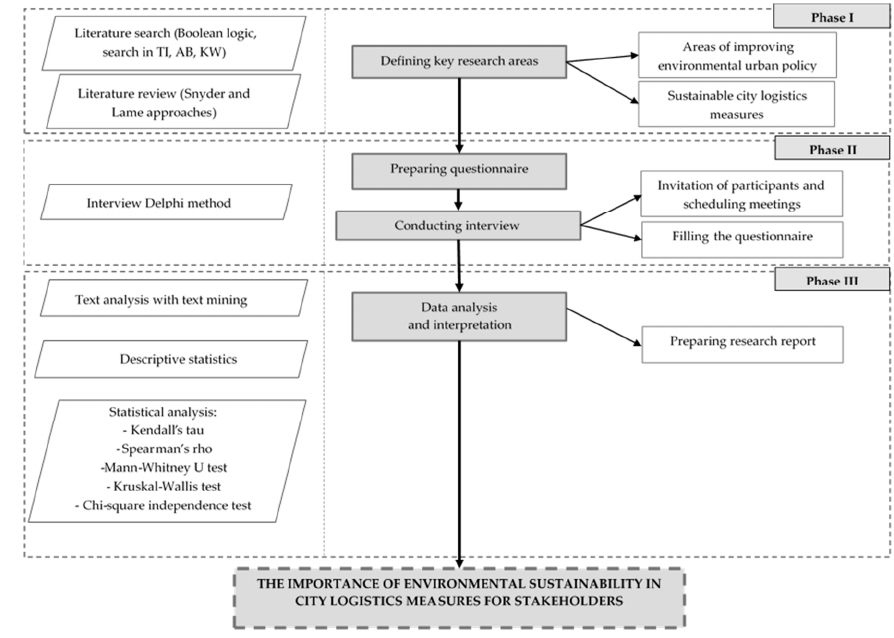
Figure 1. Research framework.